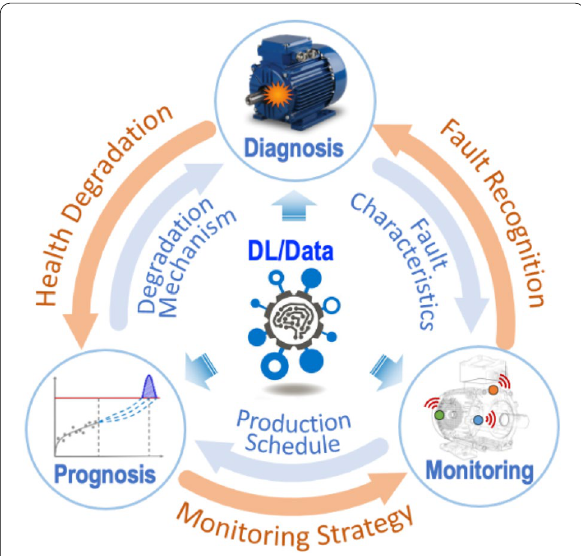
Figure 3 Interactions in an DL-enabled monitoring, diagnosis, and prognosis